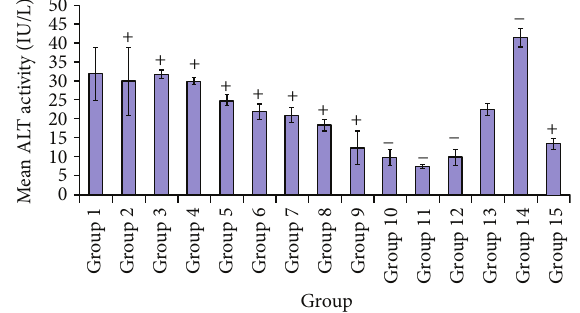
− Figure 4: Comparative effect of some plants extracts on total cholesterol level.